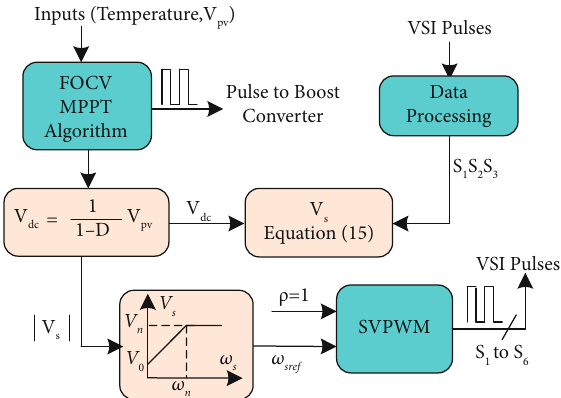
Figure 11: Schematic diagram of V / f control with FOCV MPPT